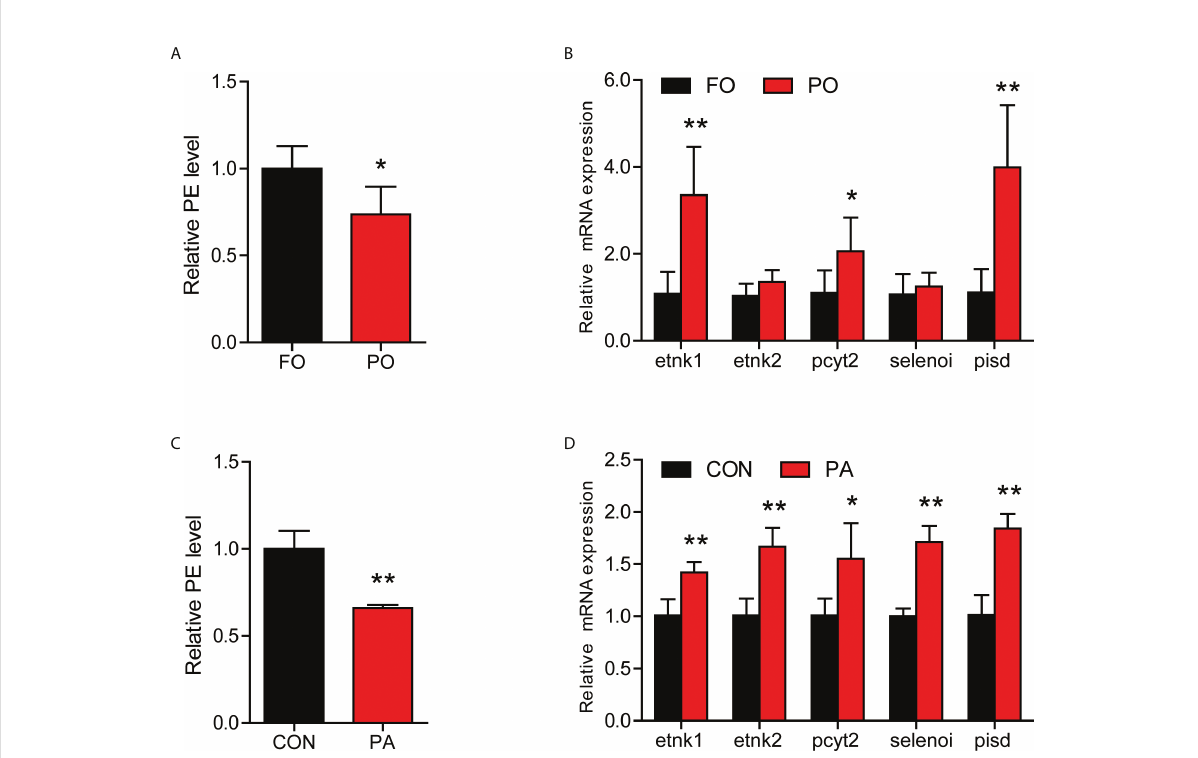
FIGURE 4 Effect of PO or PA treatment on the content of PE in the intestine or intestinal cells of large yellow croaker. (A) PE content in the intestine after different diets (n = 3). (B) Relative mRNA expression of PE synthesis related-genes in the intestine after different diets (n = 3). (C) PE content in the intestinal cells after BSA or PA treatment (n = 3). (D) Relative mRNA expression of PE synthesis related-genes in the intestinal cells after BSA or PA treatment (n = 3). Results were presented as mean ± standard deviation (SD) and analyzed using independent t -test (* P < 0.05, ** P < 0.01). FO, fi sh oil; PO, palm oil; CON, bovine serum albumin treatment; PA, palmitic acid